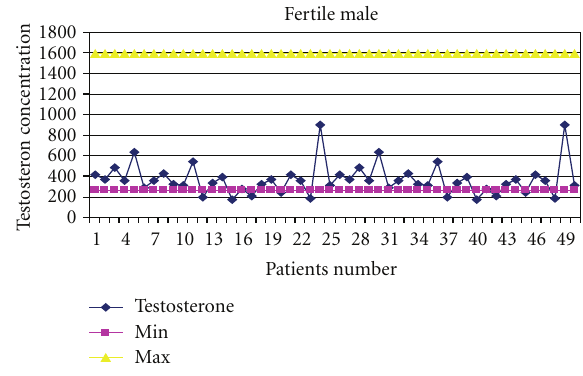
Figure 4: Ranges of testosterone concentration in the serum of fertile